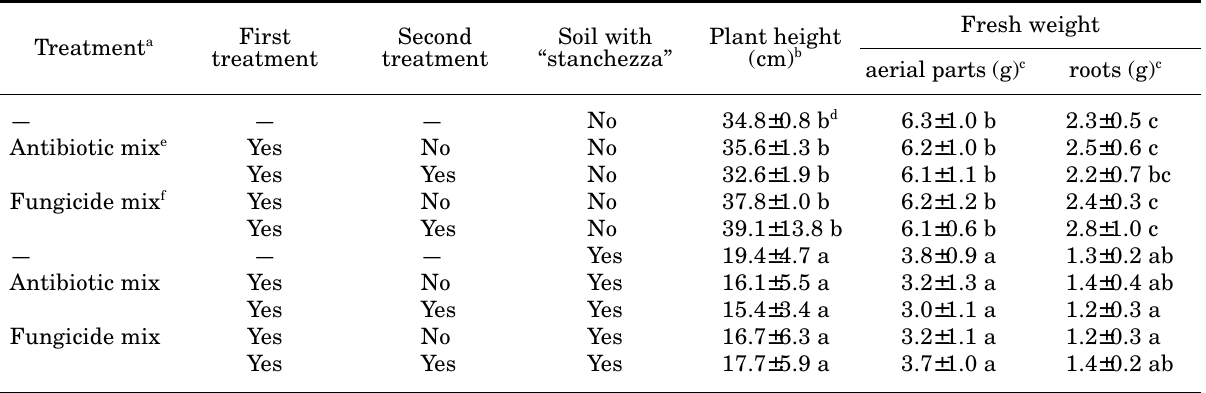
Table 6. Effect of soil treatment with a fungicide and an antibiotic mixture on “stanchezza” (soil sickness) of sweet basil. Results are expressed as plant height and f wt of the roots and aerial plant organs 45 days after sowing on March 1, 1999 (Trial 7).